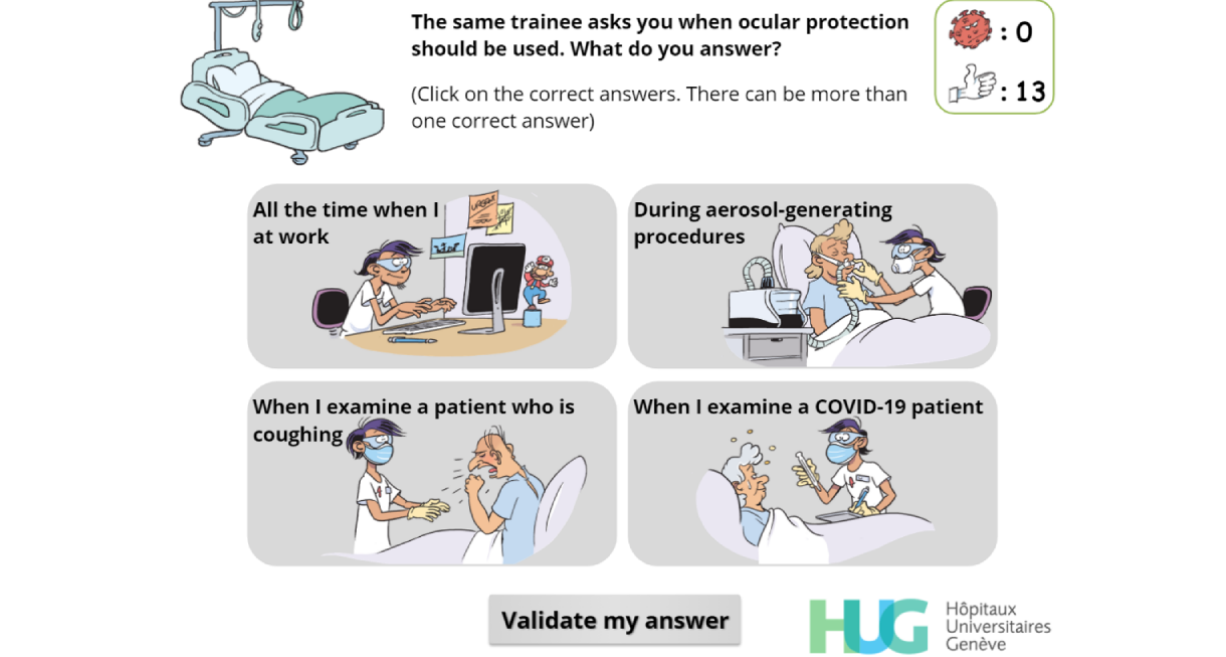
Figure 16. Multiple-choice interaction. The player must choose the situations in which eye protection should be